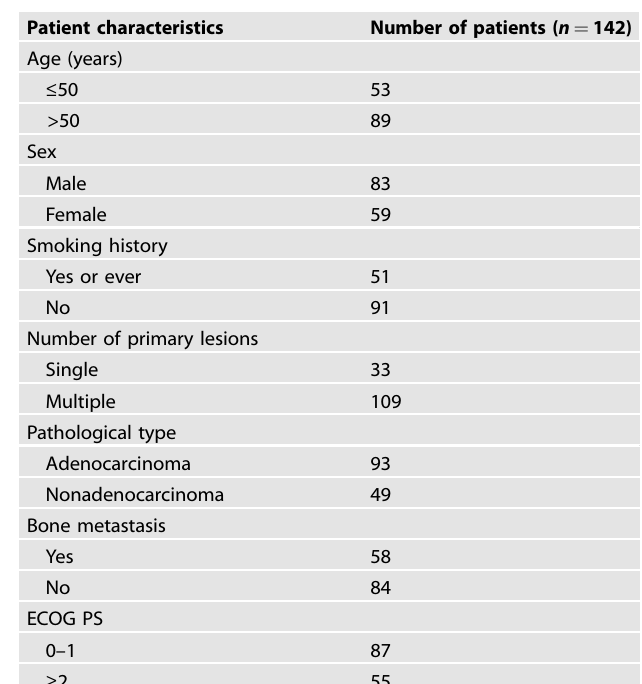
Table 1. Demographic and baseline clinical characteristics of the NSCLC